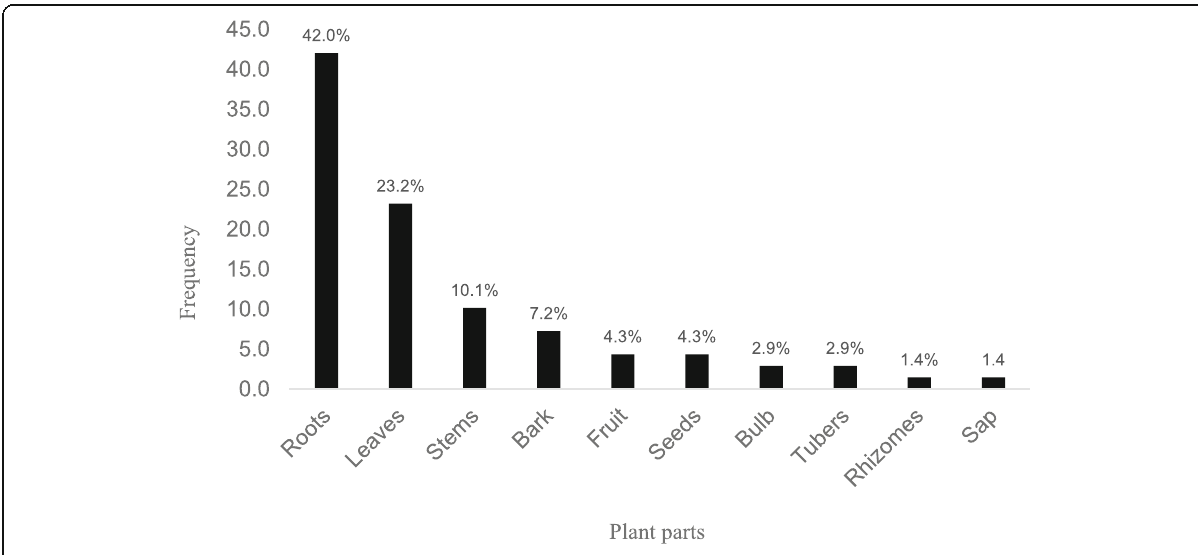
Fig. 3 Plant parts used in the management of snakebites envenomation in Acholi, Teso and Karamoja sub-regions of Uganda